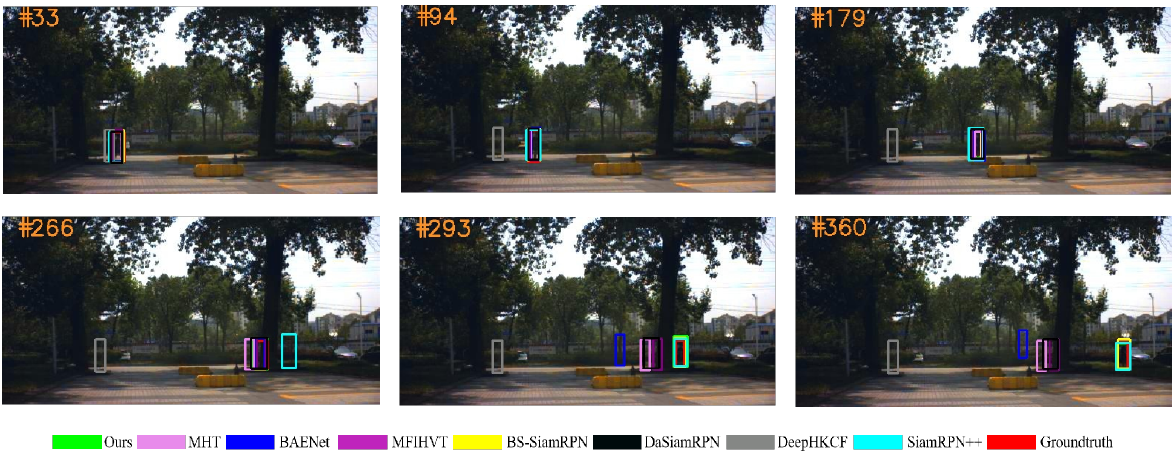
Figure 13. Qualitative results on the pedestrian2 sequence.